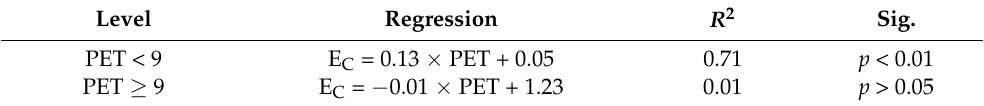
Table 7. The response of Ec to